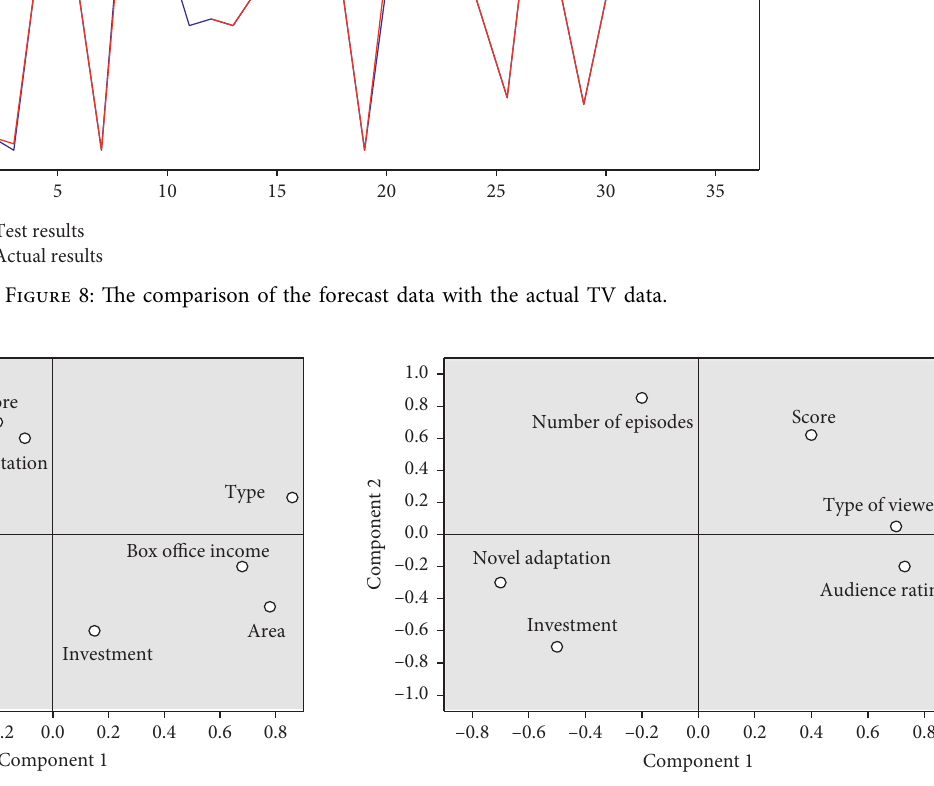
Figure 9: A composition diagram in the rotating space of films. Figure 10: A composition diagram in the rotating space of a TV